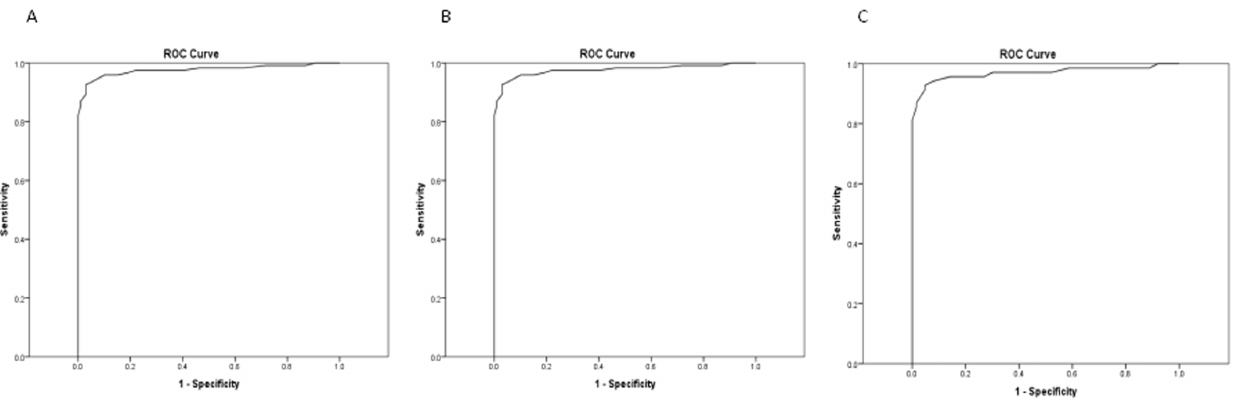
Figure 3. Receiver operator characteristic curves to identify mutation patients with a GCK mutation from controls using FPG. (A) all ages AUC 0.97 (B) # 40 years of age AUC 0.98, (C) . 40 years of age AUC 0.97.